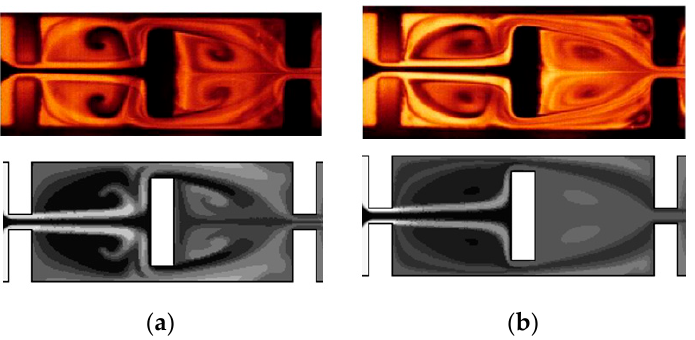
Figure 4. Comparison of the mixing images of the first two chambers for Re = 60: ( a ) At z = 32.5 μ m and ( b ) At z = 65 µ m.